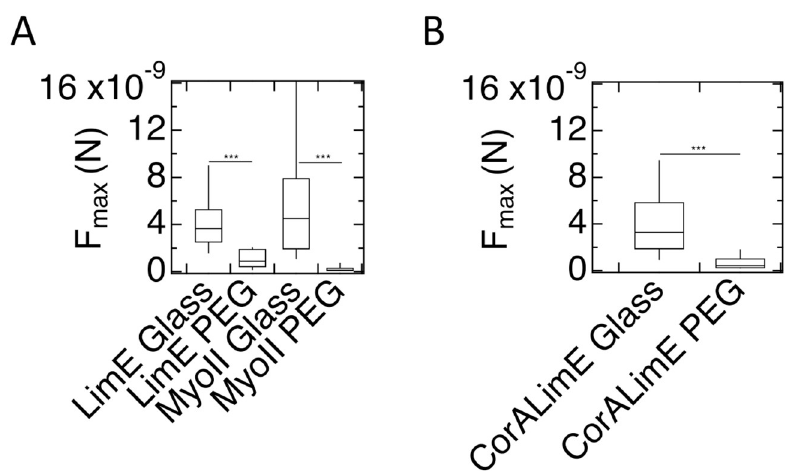
Fig 10. Maximum force of adhesion for vegetative AX2 (A) and AX4 (B) cells with cytoskeletal labeling. F PEG-gel surfaces is significantly less than on